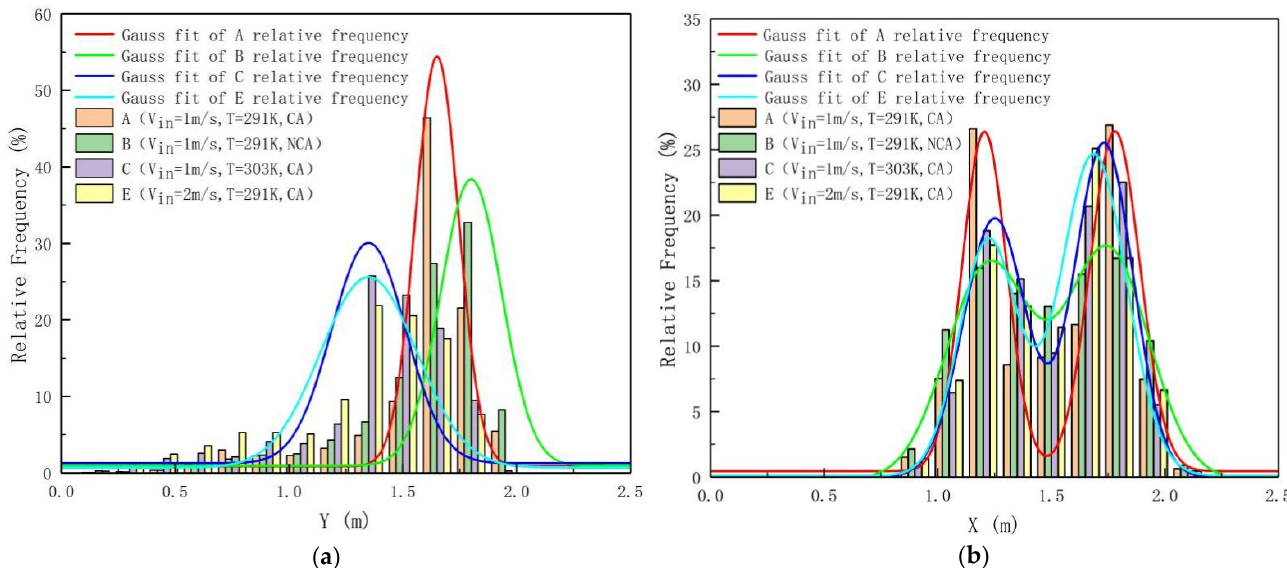
Figure 10. Wind velocity, temperature, and respiratory tract affect the frequency distribution of particulate matter: ( a ) RF in the Y direction; ( b ) RF in the X direction.